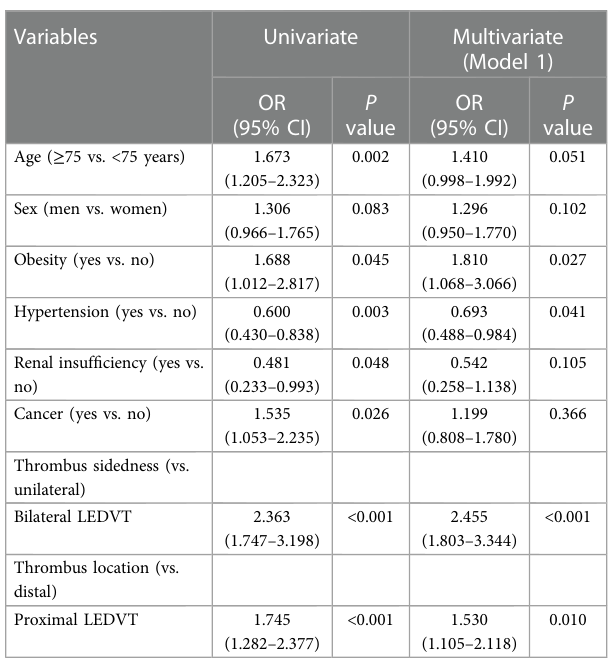
TABLE 4 Multivariate logistic regression analyses of factors associated with pulmonary embolism (Model 2).